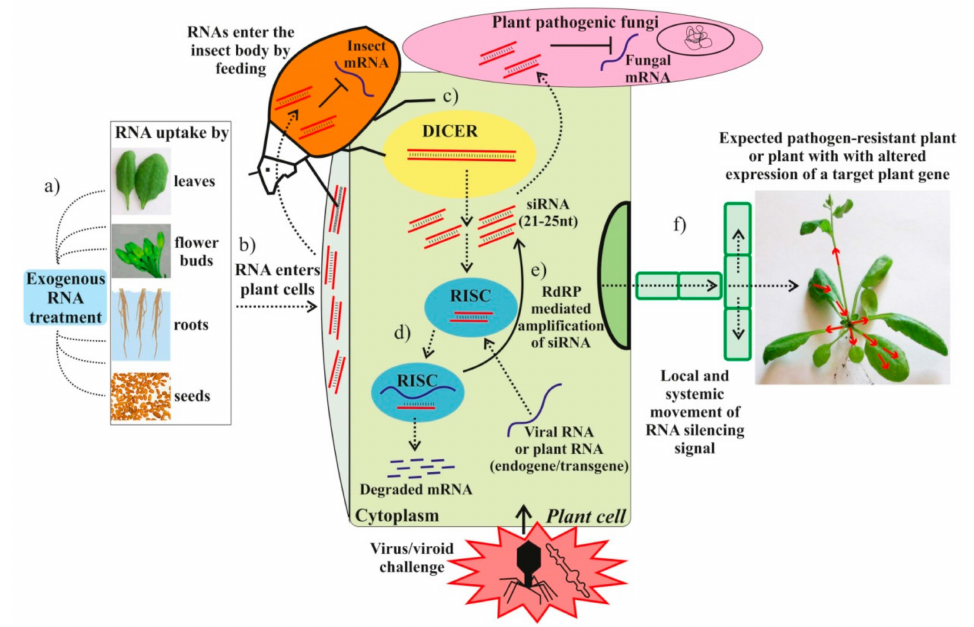
Figure 2. Schematic representation of exogenous RNA applications for RNA interference (RNAi) induction and degradation of the target plant pathogen or endogenous plant mRNAs. ( a ) Exogenous artificial RNA provided in a solution and applied onto plant leaves, flower buds, roots, or seeds. ( b ) The exogenous RNAs are taken up and transported into the cytoplasm via an undefined mechanism. ( c ) The dsRNA or hpRNA molecules are recognized by a ribonuclease, DICER-like (DICER), which cleaves the dsRNA into siRNAs. ( d ) The siRNAs are then incorporated in the RNA-induced silencing complex (RISC) that guides sequence-specific degradation or translational repression of homologous mRNAs. ( e ) The components of the siRNA / mRNA complex can be amplified into secondary siRNAs by the action of RNA-dependent RNA-polymerase (RdRP). ( f ) Movement of the RNA silencing signal between plant cells and through the vasculature. Dashed arrows depict di ff erent steps of the RNAi induction process and dsRNA / siRNA movement between plant cells and plant pathogens. The solid arrow depicts the RdRP-mediated amplification of siRNA. Red arrows depict the local and systemic movement of the RNA silencing signal in the